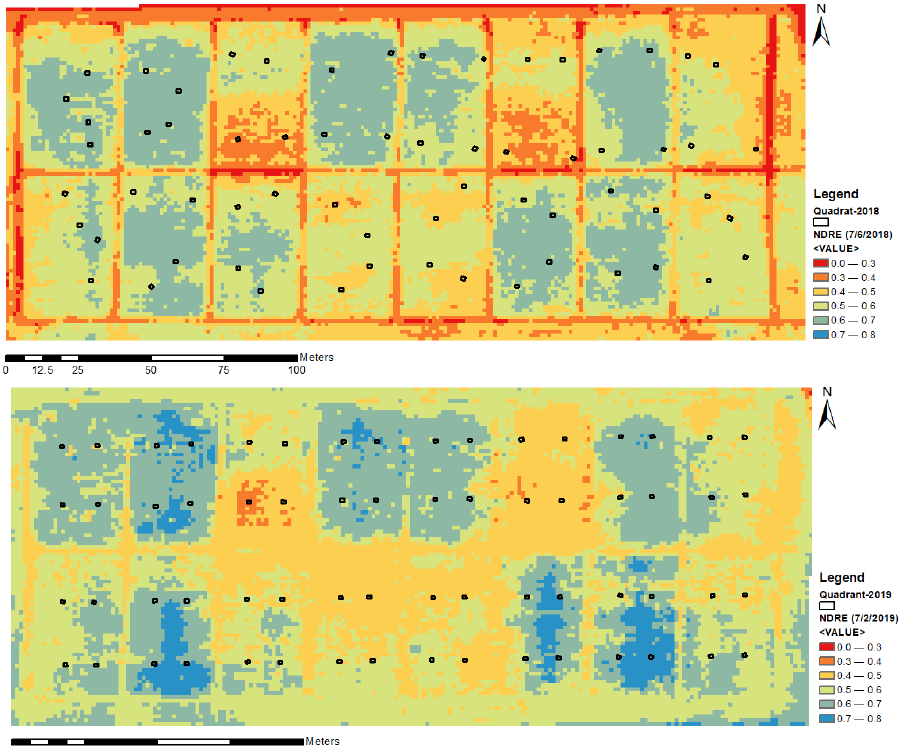
Figure 8. Aggregated NDRE maps during the early-summer growing season (6 July 2018 and 2 July 2019) with 1 m × 1 m resolution and quadrat locations in 2018 and 2019.